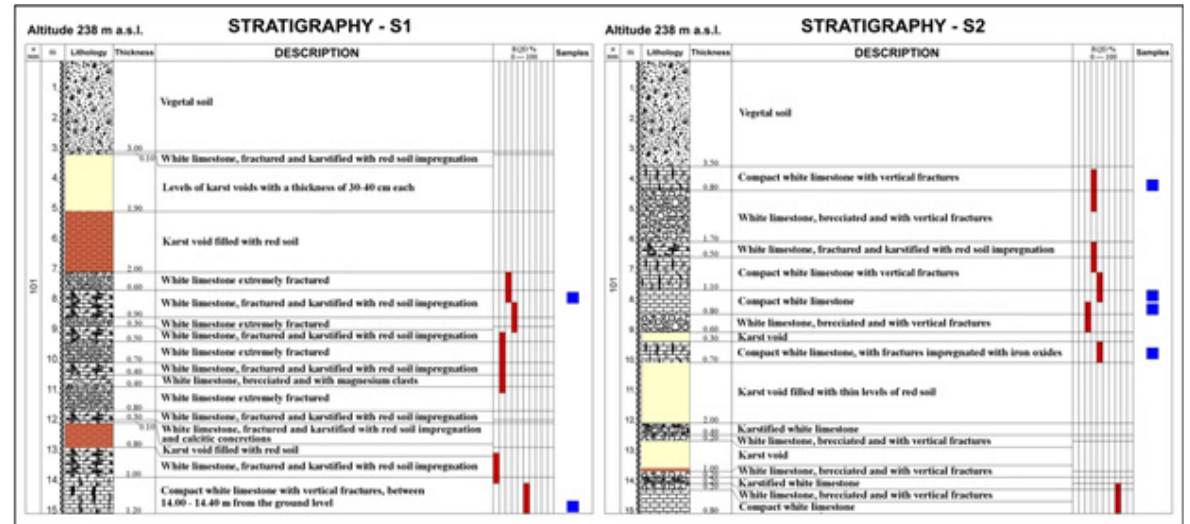
Figure 6: Stratigraphies obtained from rotation drills with continuous coring, RQD trend along verticals and depth of the rock samples for geotechnical laboratory